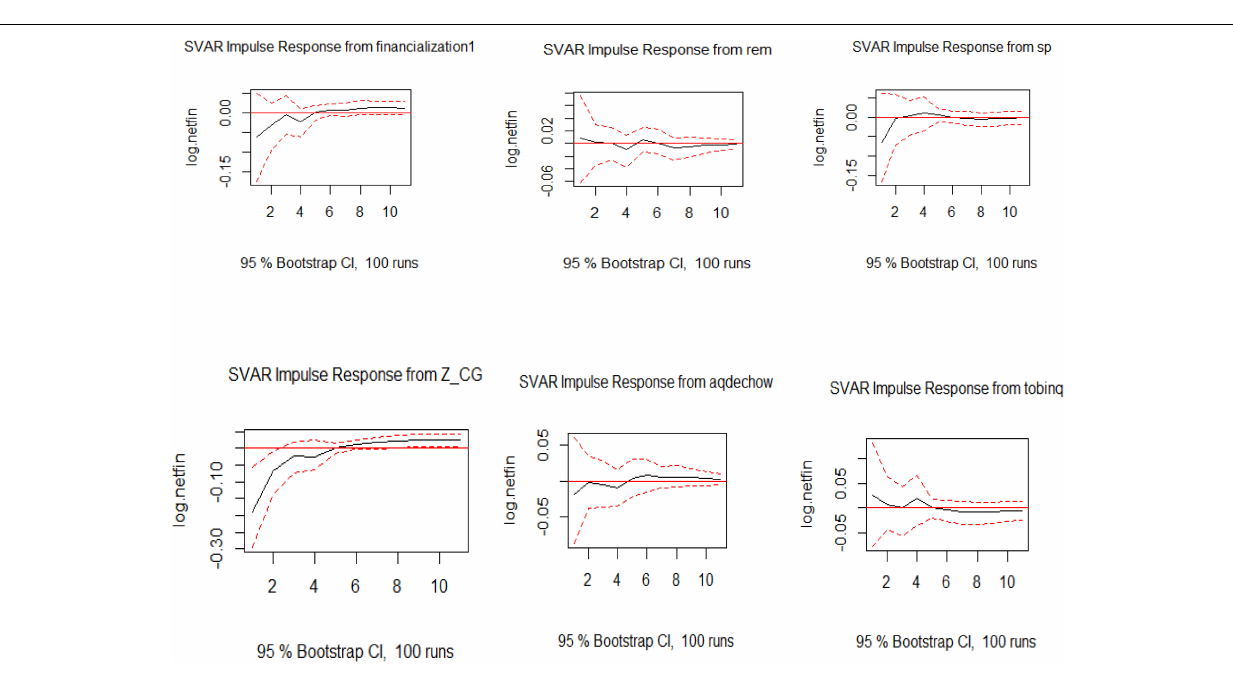
FIGURE 2 | Visualization of IRF for SVAR for Model